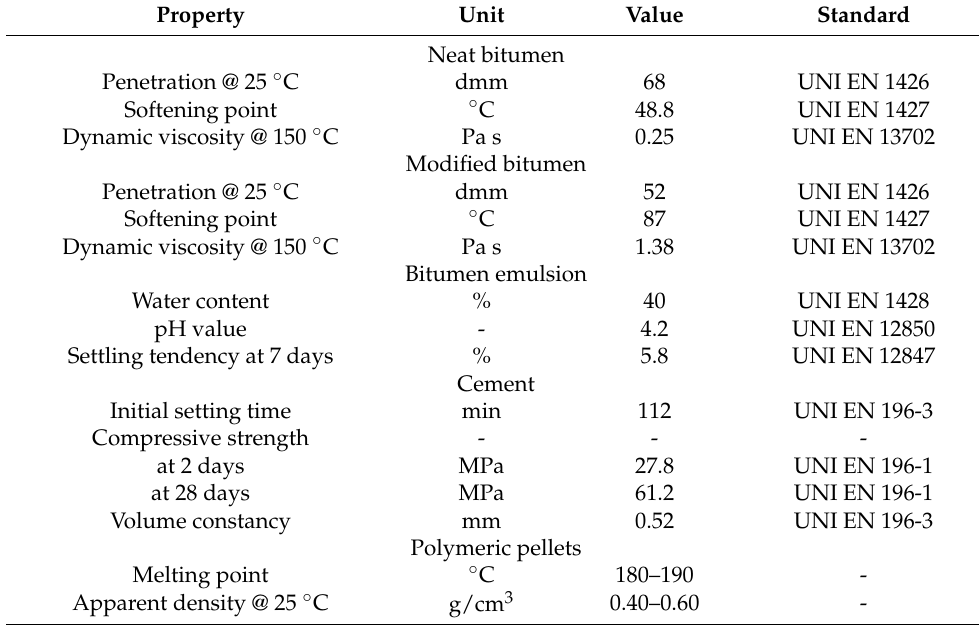
Table 3. Main properties of the neat and modified bitumen, bitumen emulsion, cement, and polymeric